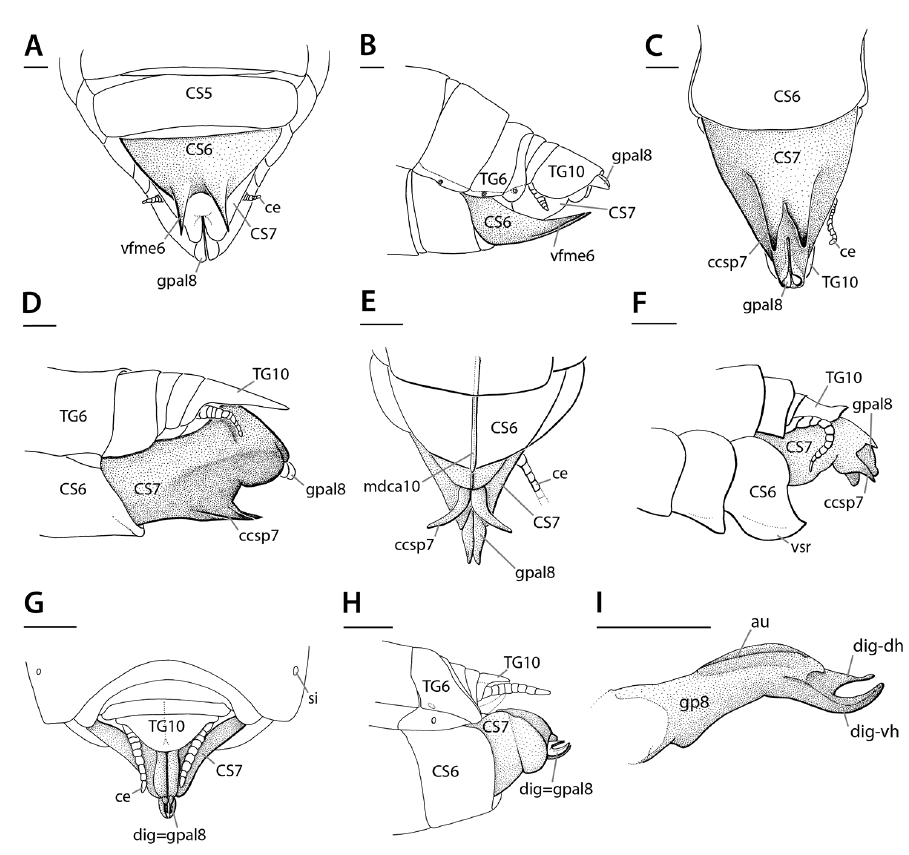
Figure 17. Annotated illustrations of digging structures on female genitalia. A – B Eremiaphilidae-type digging spine: Eremiaphila sp. terminalia A ventral view B lateral view. C – D Rivetina -type digging spine: Rivetina Berland & Chopard, 1922 terminalia C ventral view D lateral view. E – F Chroicoptera- type dig- ging spine: Chroicoptera longa Giglio-Tos, 1915 terminalia ( E ) ventral view; Chroicoptera saussurei Giglio- Tos, 1915 F lateral view. G – I Ligaria -type digging spine: Ligaria Stål, 1877 G dorsal view H lateral view I lateral view (left side) of the left gonapophysis 8. Note that in the Ligaria- type, the digging structures are gonapophyses 8. Figures A – E and G – I reproduced and adapted from Wieland (2013); figure F re- produced from Wieland 2013, which was modified from Kaltenbach 1996. Abbreviations: au = aulax; ccsp7 = centrocoxosternal processes 7; ce = cercus; CS5–7 = coxosternite 5–7; dig-dh = digging device, dorsal hook; dig-vh = digging device, ventral hook; mdca10 = middorsal carina 10; vfme6 = ventromedian expansion (of ventral fold); gpal8 = apical lobe of gonapophysis 8; si = spiracle; TG6–10 = tergite 6–10. Scale bars: 1